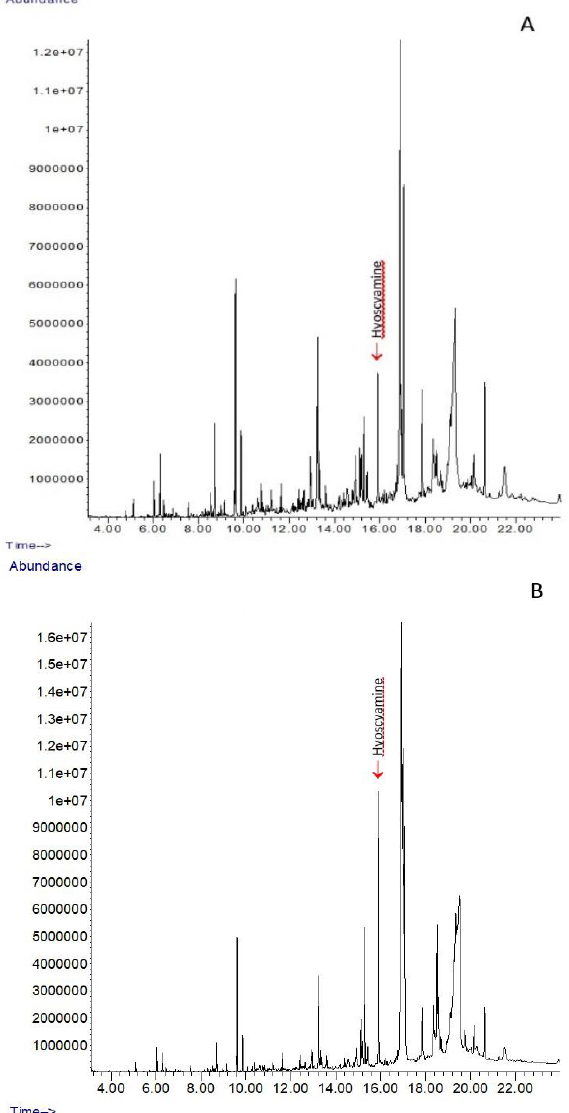
Figure 2. Chromatograms (detector response — abundance vs. retention times in min) obtained from the GC-MS analysis of D. stramonium extracts from capsules. ( A ) Healthy control plants, ( B ) Plants elicited with PMMoV. The peak representing hyoscyamine is indicated.